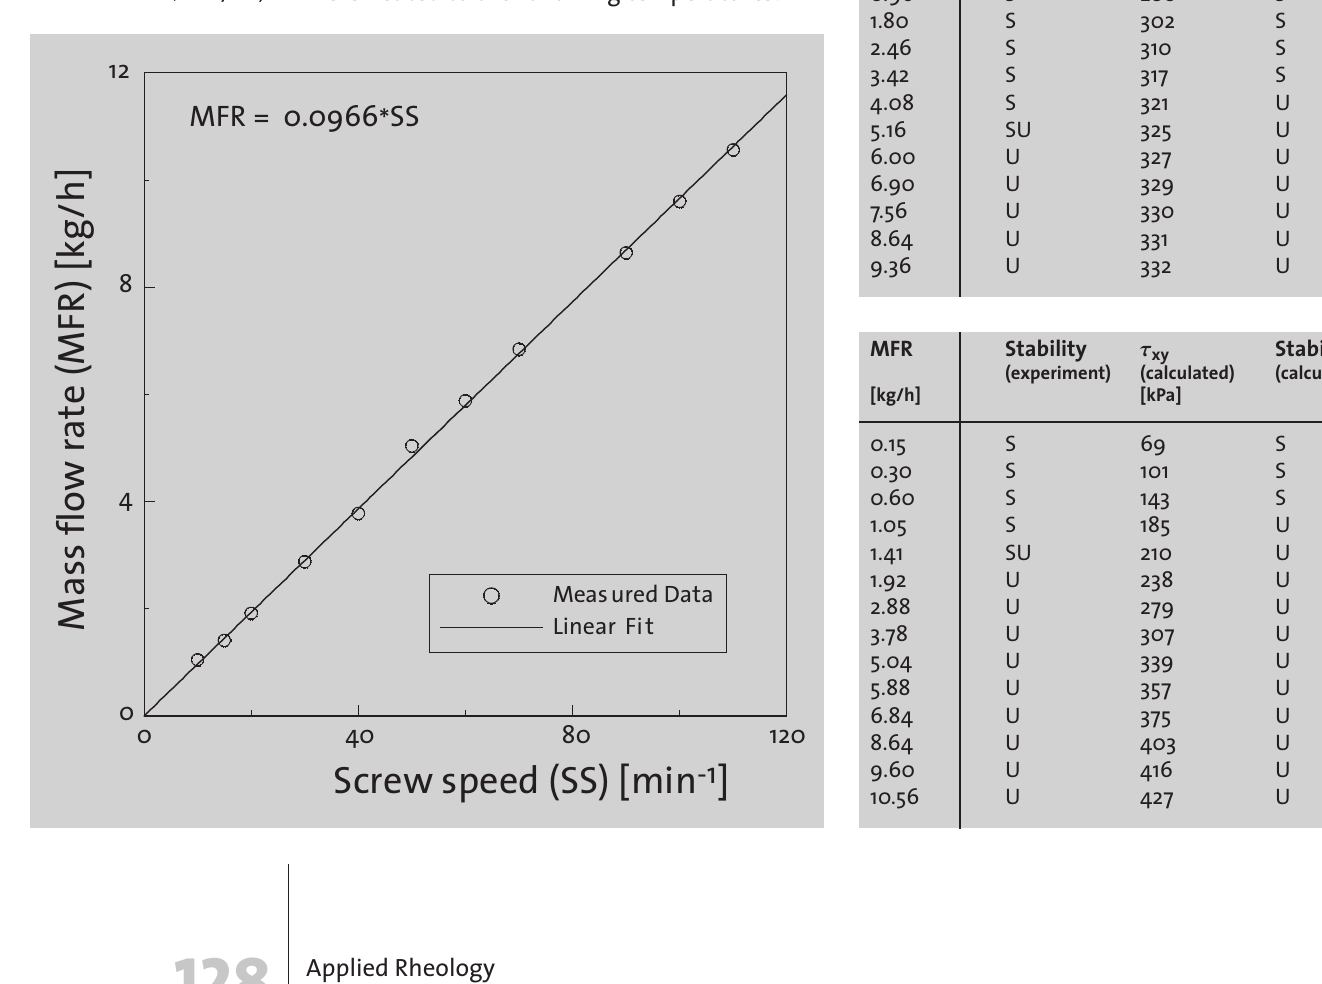
Figure 3 (left below): Extruder mass flow rate vs. screw speed (Exact, T = 170˚C). Table 1 (right above): Experimental and theoretical results for mLLDPE Exceed in film blowing process (mLLDPE Exceed, T = 150˚C). Table 2 (right below): Experimental and theoretical results for mLLDPE Exact in film blowing process (mLLDPE Exact, T =